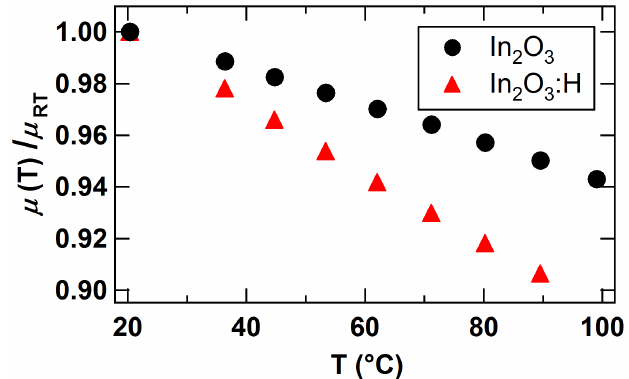
Figure 8. Carrier mobility at different temperatures normalized to mobility at = 84 . 8 cm 2 /Vs, room temperature ( µ ) for a post-annealed In O :H film ( µ 2 3 RT RT n = 1 . 06 × 10 20 e/cm 3 ) deposited at p (H O) = 7 . 5 × 10 − 4 Pa and a polycrystalline undoped 2 RT = 52 . 7 cm 2 /Vs, n = 1 . 11 × 10 20 e/cm 3 ) deposited at 400 ◦ In O film ( µ 2 3 RT RT